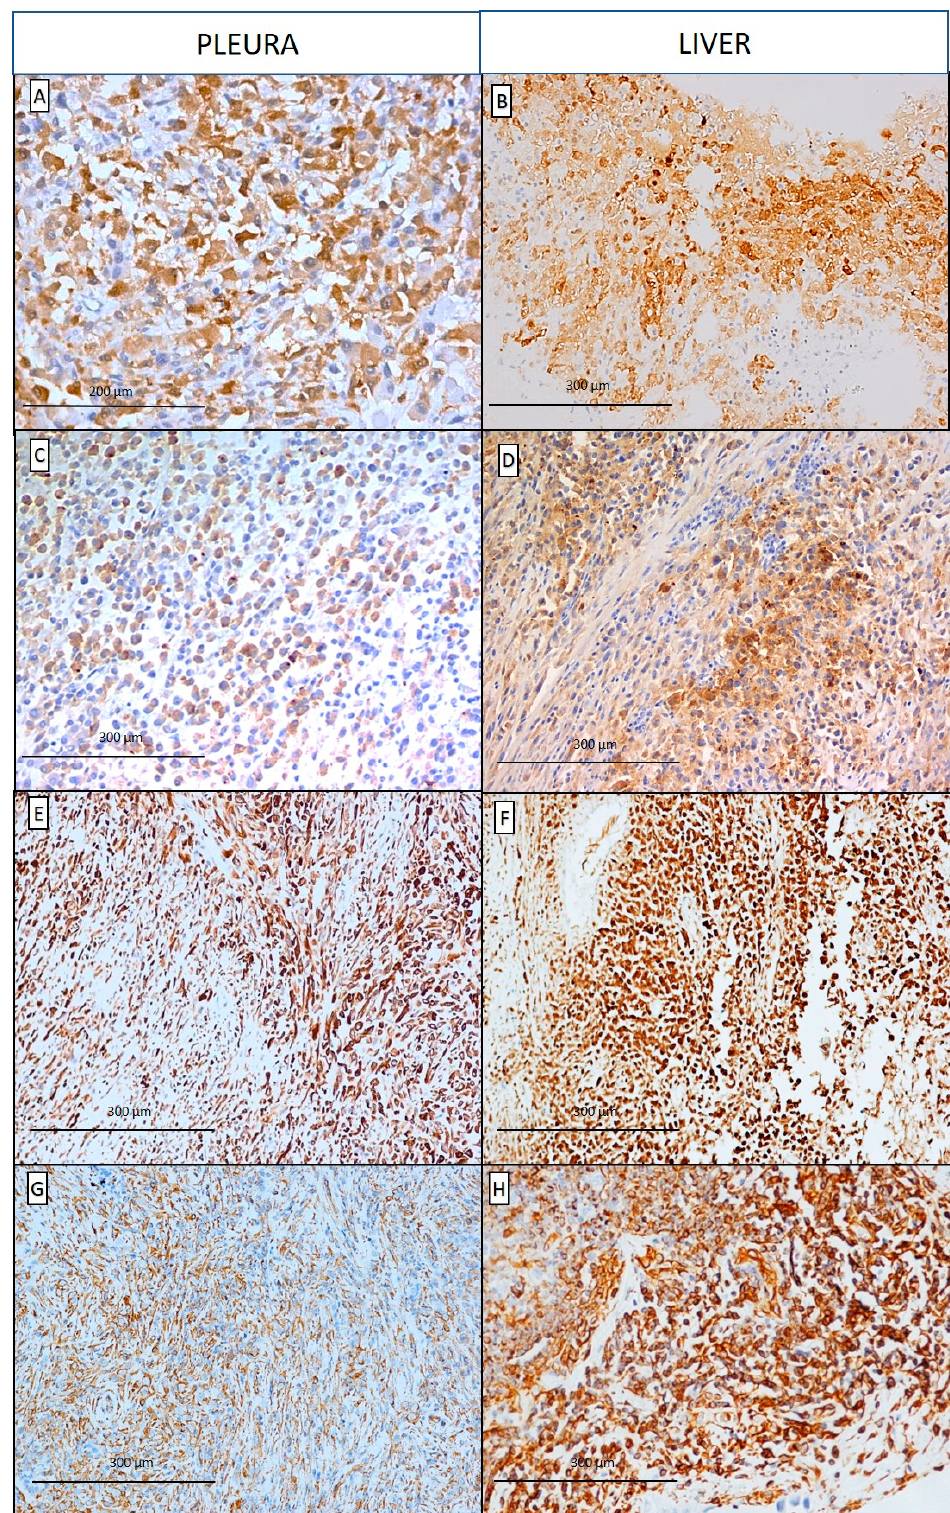
Figure 2. According to the recent guidelines [1,2] a panel of immunohistochemistry antibodies was used in both tumors, eliciting positive reactions to: calretinin ( A, scale bar: 200 µm; B , scale bar: 300 µm), podoplanin (D2-40) ( C , D , scale bar: 300 µm), CK5/6 ( E , F , scale bar: 300 µm), and vimentin ( G , H , scale bar: 300 µm), and negative reactions to CEA, TTF-1, p40, CD34, HMB45, Melan-A, CK7, CK19, CK20, PAX8, FLI-1, and BAP1 (using lymphocytes as positive control). Immunostaining for WT-1 was also performed, resulting negative in both lung and